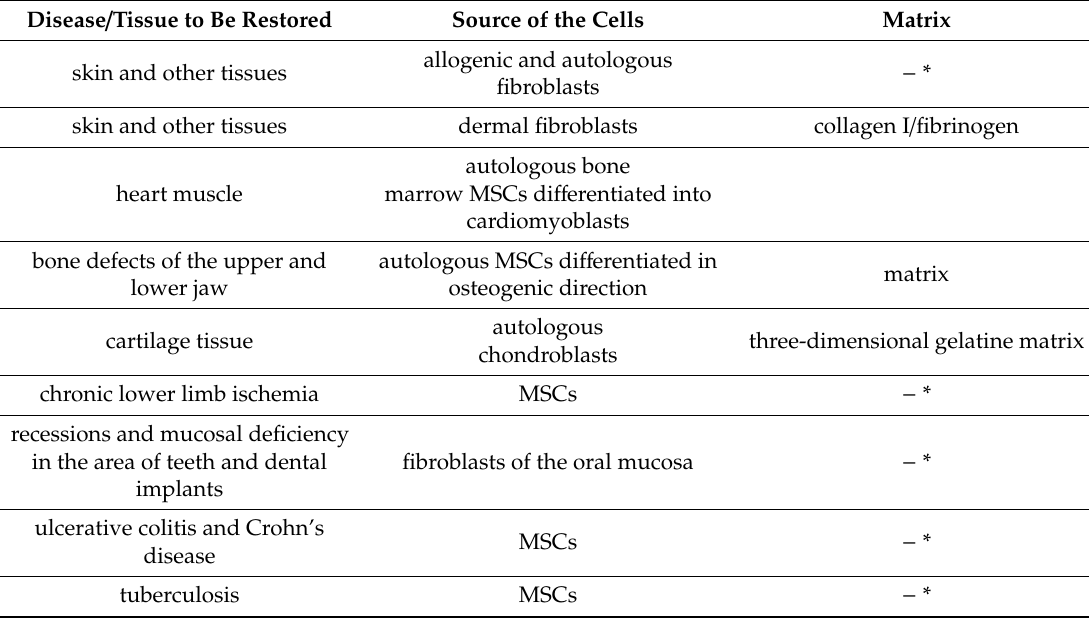
Table 2. Technologies and products registered in Russia by the end of 2011 to correct tissue defects. Disease / Tissue to Be